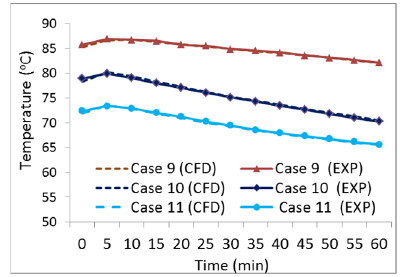
Figure 4. Operating condition of the hot water inlet for cases 9–11.